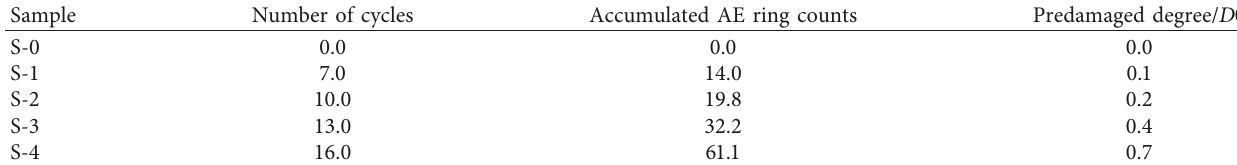
Table 1: Predamaged degree of a rock sample.